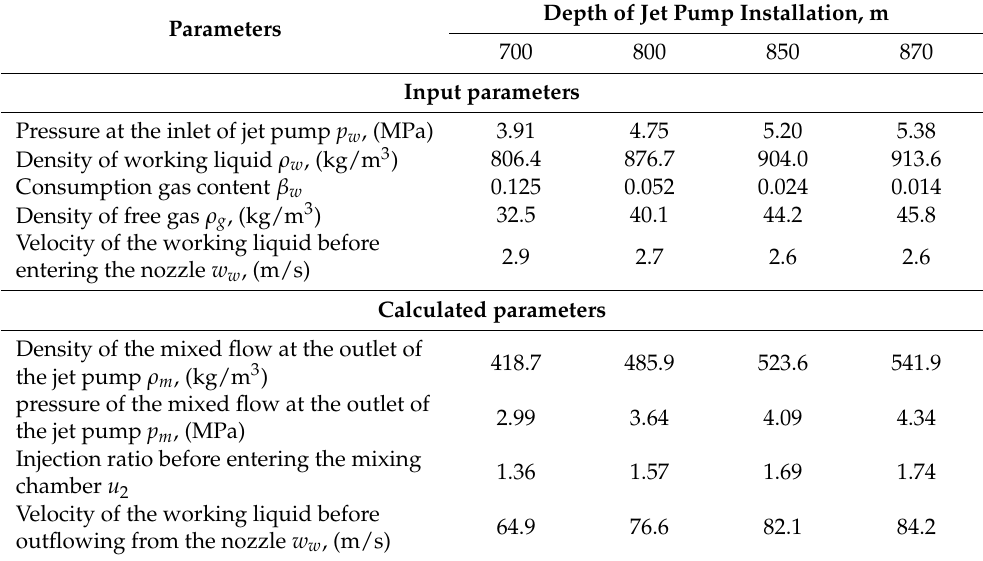
Table 2. Input and calculated parameters of the high-pressure oil-gas jet pumps during their installa- tion in oil well at different depths